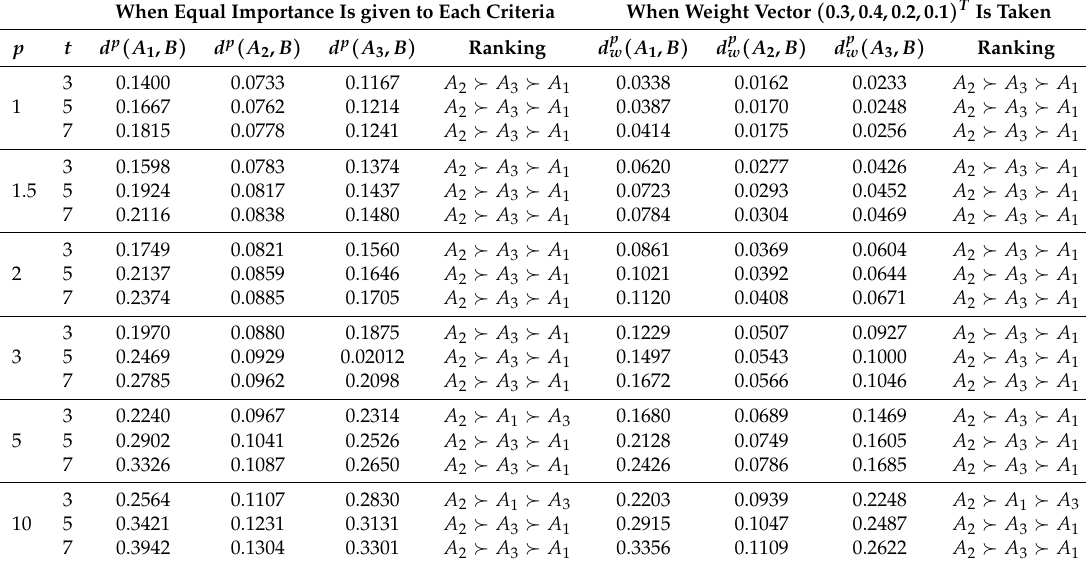
Table 3. Results of classification of given sample using proposed distance measure.